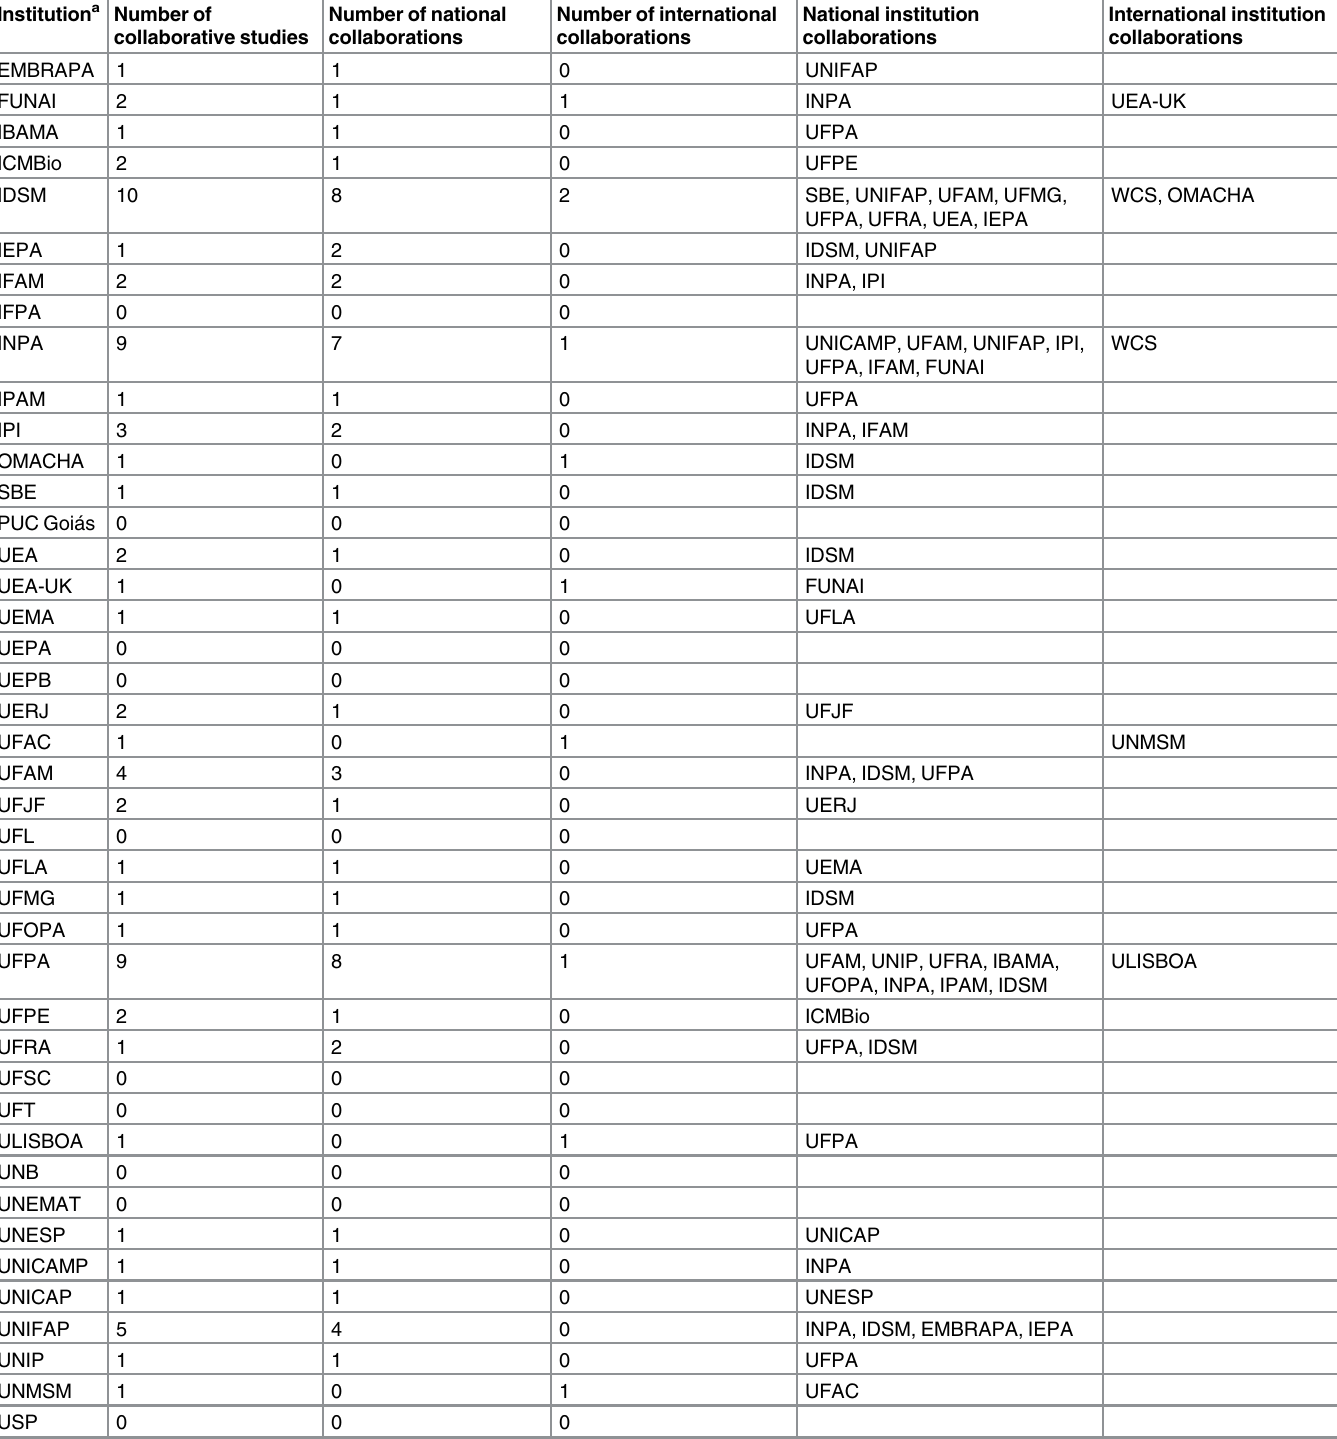
Table 1. List of institutions that were affiliated with the first and last authors of 105 studies of Amazonian aquatic species published from 1990 to 2014 and their respective collaborations with national and international institutions. Institution a Number